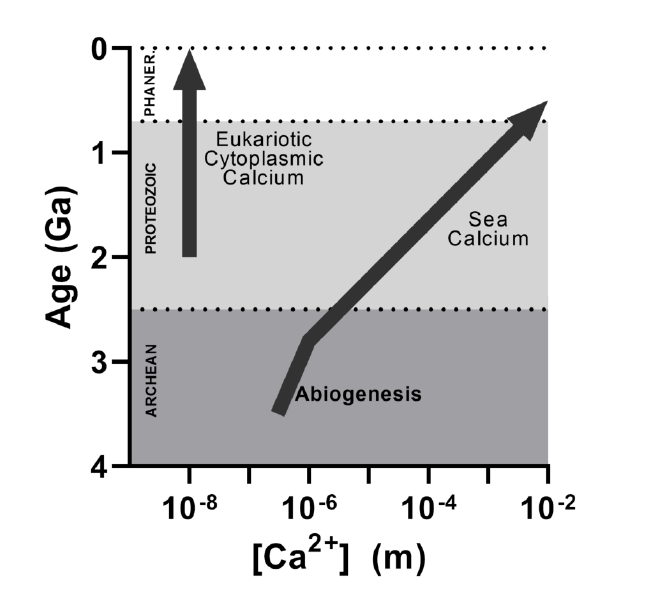
Figure 2. Calcium concentration as a function of time in the sea and in cytoplasmic eukaryotic